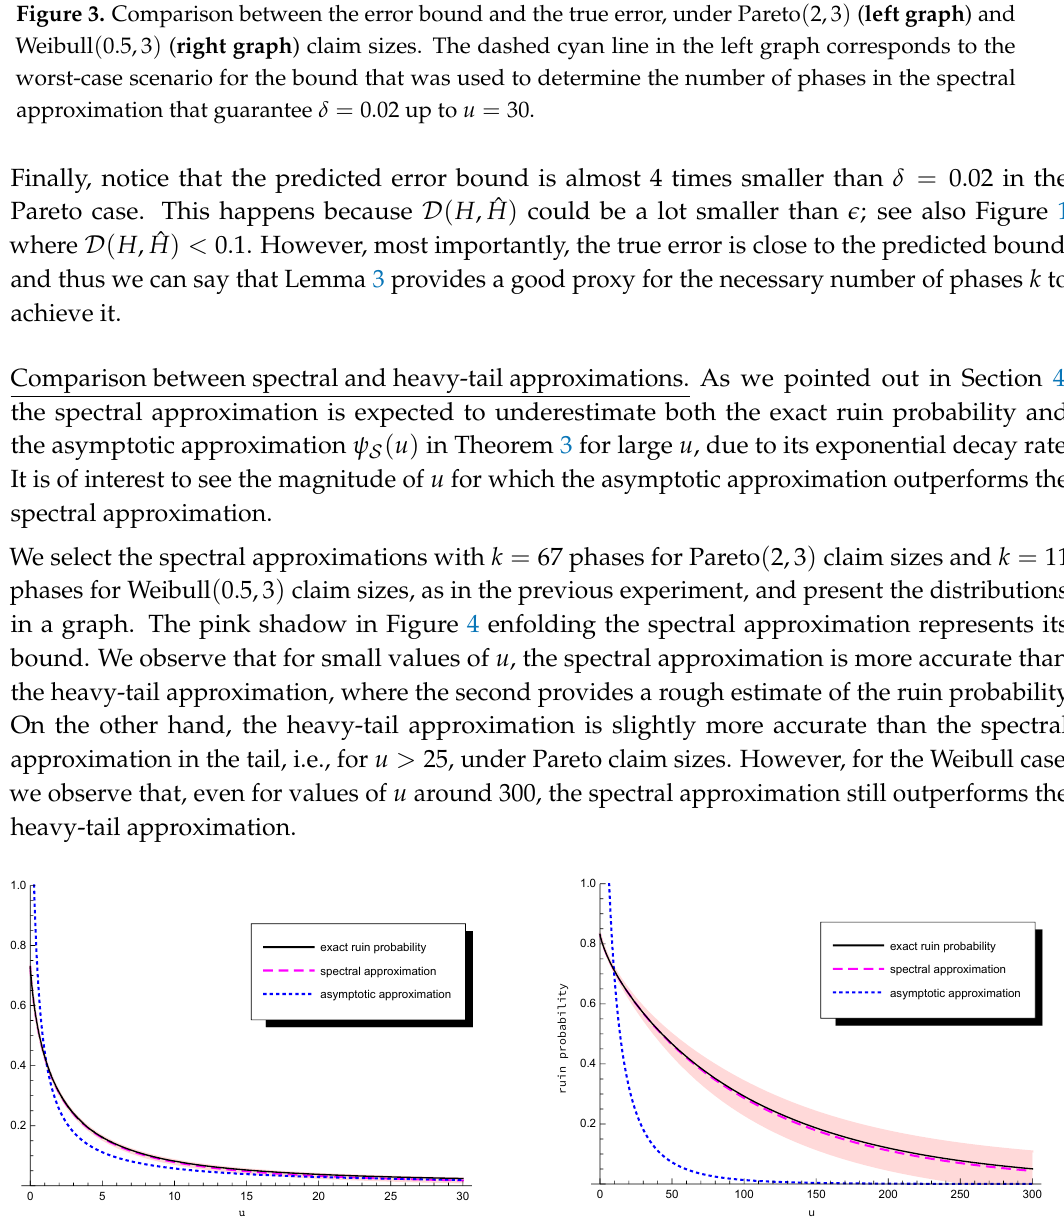
Figure 4. Comparison between the spectral approximation with k = 67 under Pareto ( 2,3 ) claim sizes ( left graph ) and with k = 11 under Weibull ( 0.5,3 ) claim sizes ( right graph ) and the heavy-tail